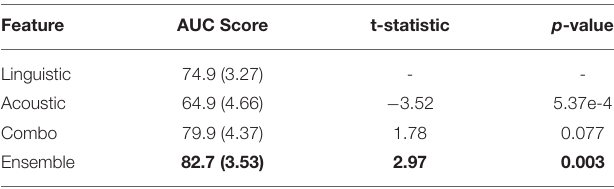
TABLE 2 | Comparisons of behavioral marker performances on 100 subtopic-stratified shuffle splits using semi-structured conversations.